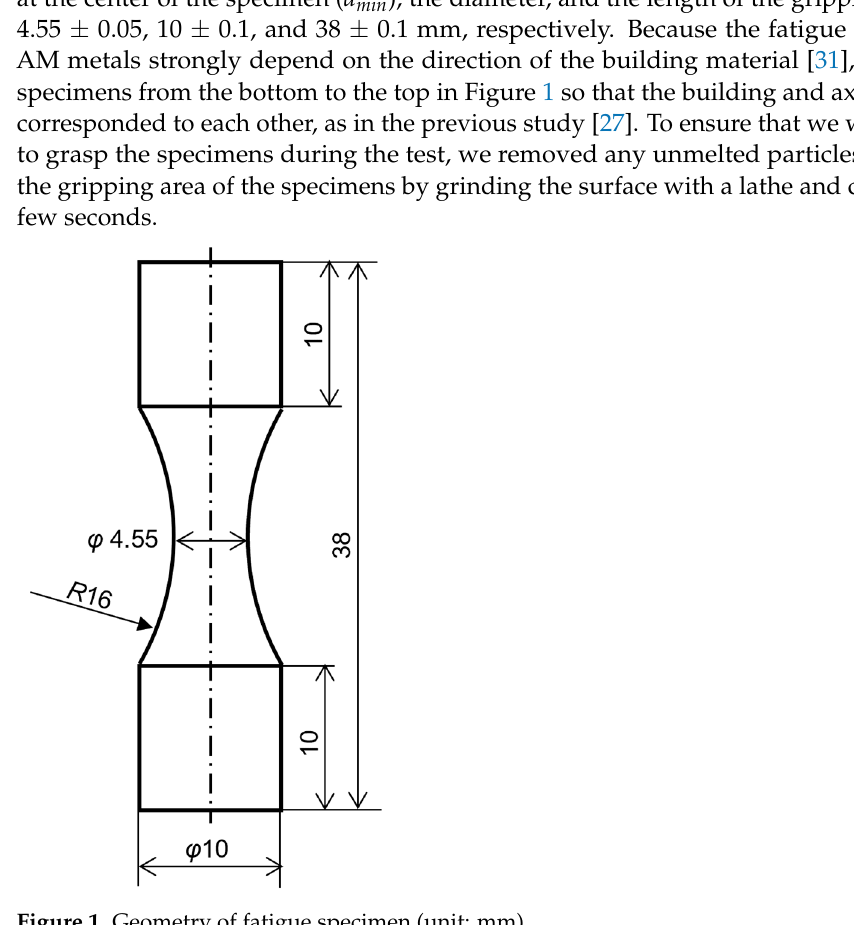
Figure 1. Geometry of fatigue specimen (unit: mm).